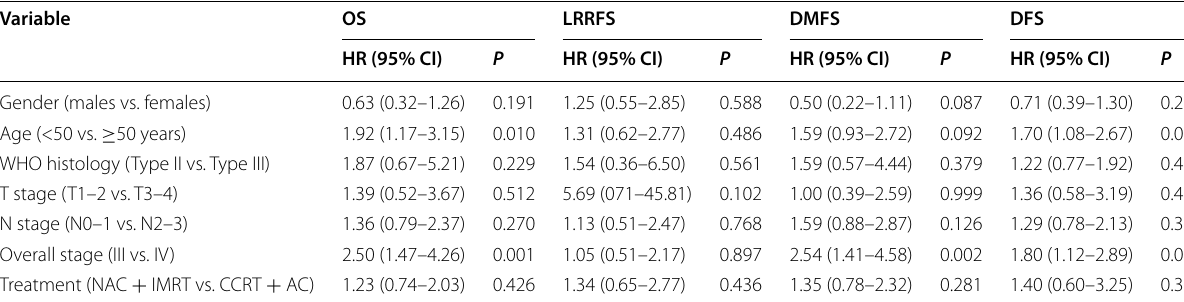
Table 6 Multivariate analysis of prognostic factors for patients with locoregionally advanced NPC Variable OS LRRFS